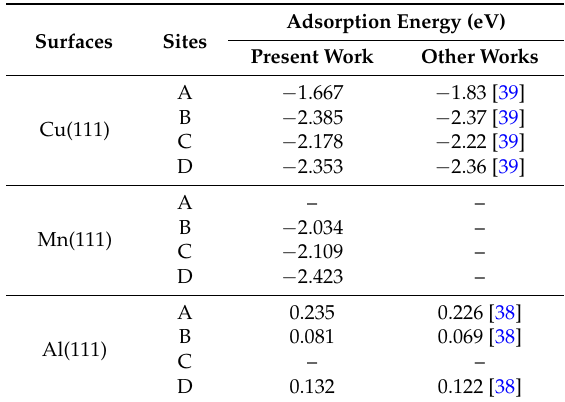
Table 4. Adsorption energy of hydrogen on Cu(111), Mn(111) and